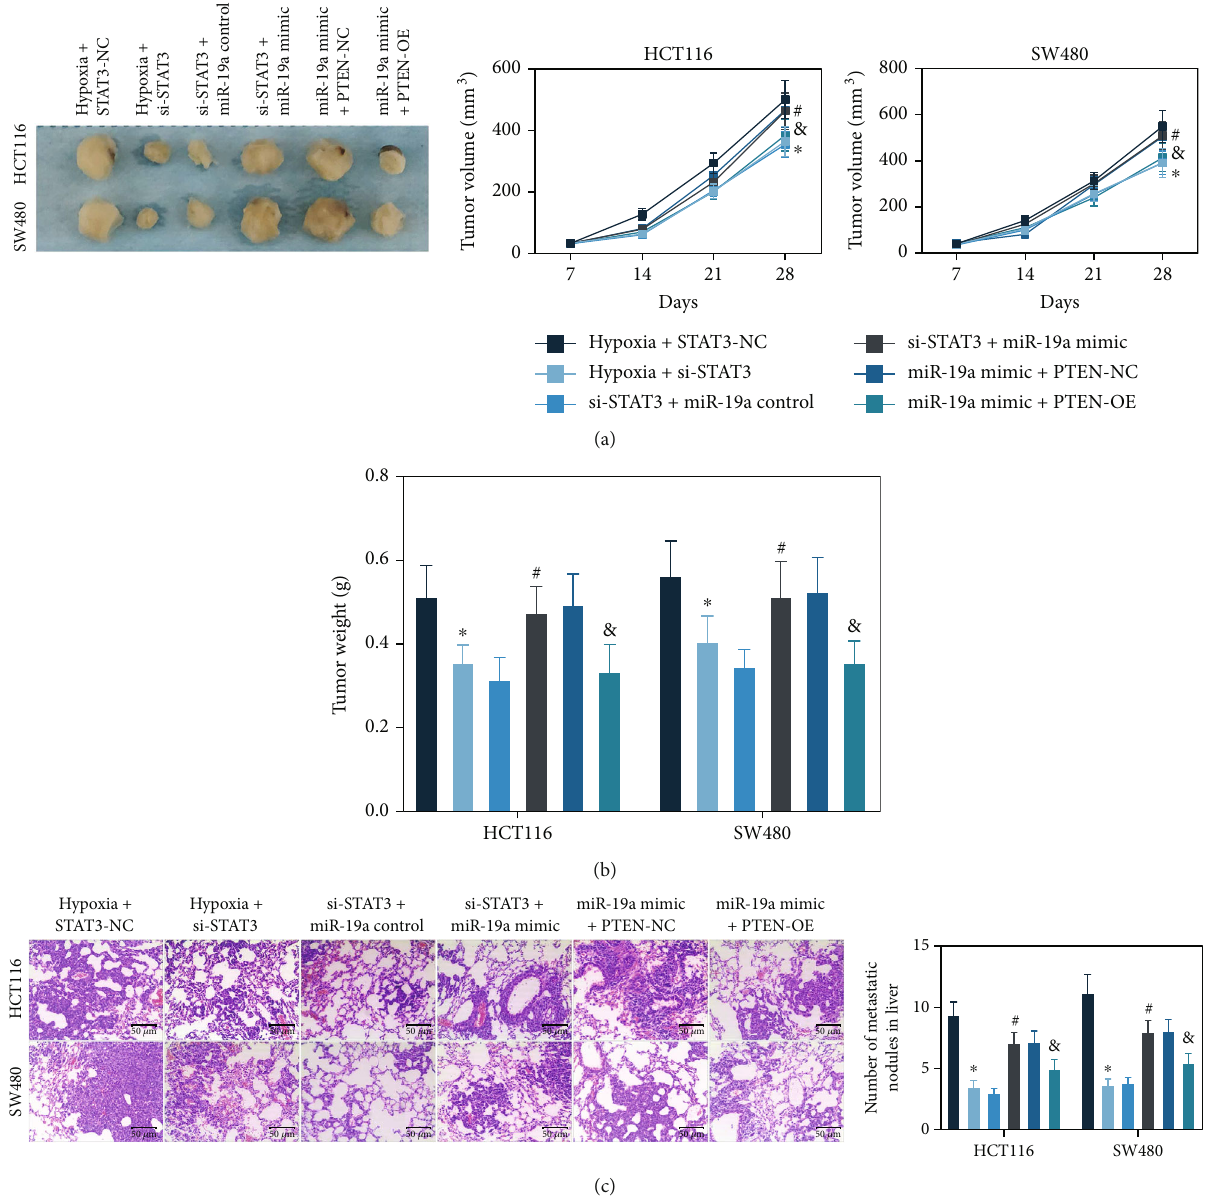
Figure 7: The STAT3/miR-19a/PTEN axis a ff ects CRC malignancy in vivo : (a) volume of the xenograft tumors in nude mice ( ∗ #& p < 0 : 05 , two-way ANOVA); (b) weight of the xenograft tumors in nude mice ( ∗ #& p < 0 : 05 , two-way ANOVA); (c) number of metastatic nodules in murine liver tissues examined by HE staining ( ∗ #& p < 0 : 05 , two-way ANOVA). N = 5 in each group. ∗ Compared to the hypoxia + STAT3- NC group; # compared to the si-STAT3 + miR-19a control group; & compared to miR-19a mimic + PTEN-NC